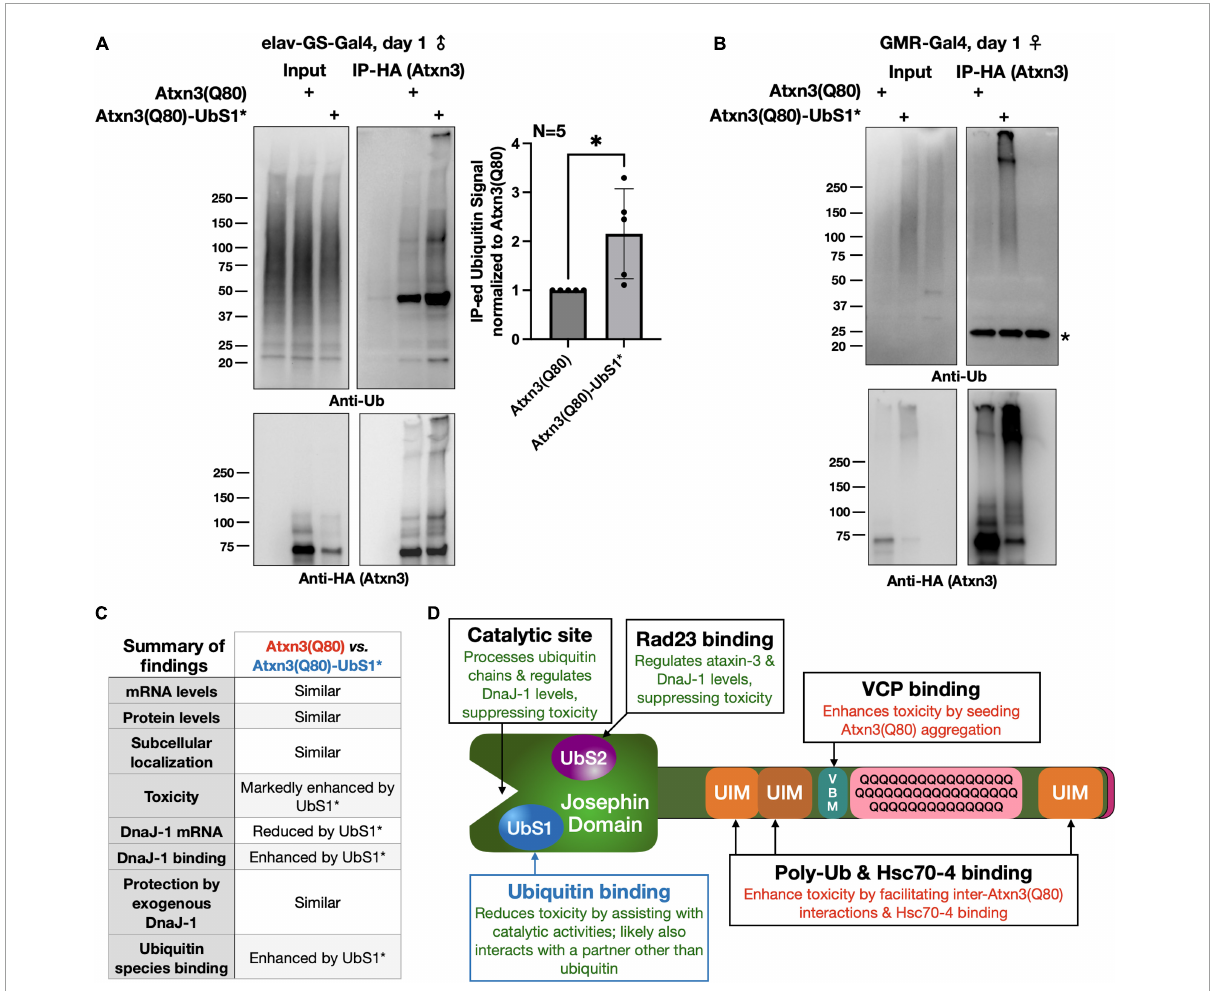
FIGURE6 Atxn3(Q80)-UbS1 ∗ co-precipitates more ubiquitinated species than Atxn3(Q80). (A,B) Western blots of Atxn3(Q80)-HA co-IPs. Ub, ubiquitin; (A) Adult neuronal expression; (B) Eye expression. Graph: Quantification of results on the left and additional, independent repeats. ∗ p < 0.05, Wilcoxon test. Some of the ubiquitinated species on the anti-ubiquitin blot may include ubiquitinated Atxn3 itself, which is ubiquitinated and interacts with other Atxn3 proteins (Todi et al., 2007a, 2009, 2010; Johnson et al., 2021). (C) Summary of the findings presented in this study. (D) Graphical summary of the role of various Atxn3 domains, based on our studies in Drosophila models of SCA3; references are in main